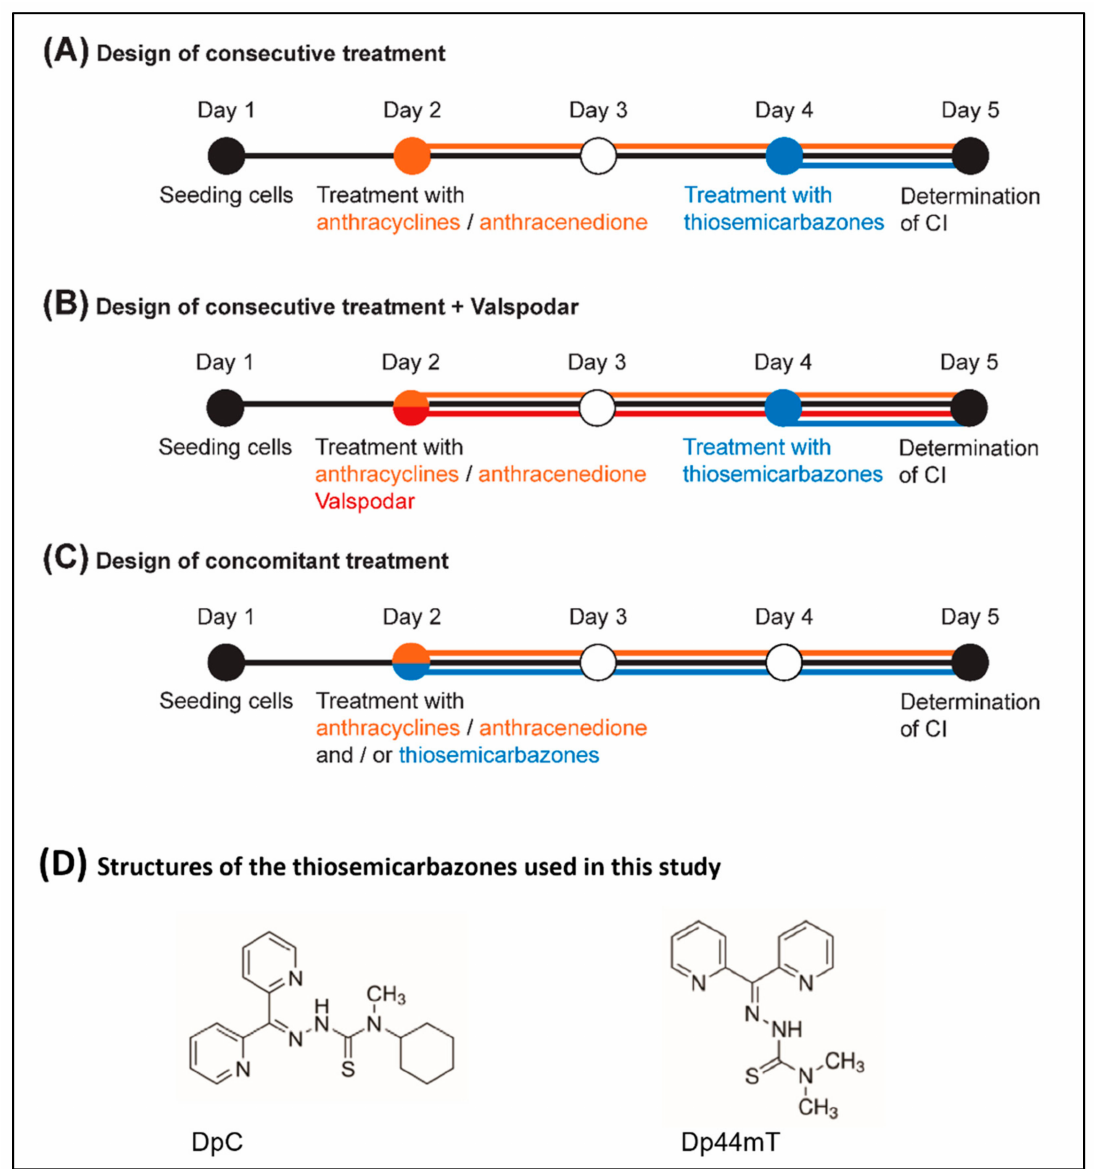
Figure 3. The three different combination treatment designs used in this study. ( A ) The de- sign of consecutive treatment included the pretreatment of cells for 48 h with an anthracy- cline/anthracenedione (either DOX, DAU, or MIT), and then either DpC or Dp44mT was added to the cells undergoing anthracycline/anthracenedione treatment for a period of 24 h. ( B ) To examine whether the mechanism of synergy was based on Pgp transport activity, Valspodar, a selective in- hibitor of Pgp, was added to the design of consecutive treatment. ( C ) In the design of concomitant treatment, both anthracycline/anthracenedione (either DOX, DAU, or MIT) and thiosemicarbazones (either DpC or Dp44mT) were added in combination to the cells and proliferation was evaluated after 72 h. ( D ) Structure of di-2-pyridylketone 4-cyclohexyl-4-methyl-3-thiosemicarbazone (DpC) and di-2-pyridylketone 4,4-dimethyl-3-thiosemicarbazone (Dp44mT). The computational analyses of synergy showed that the combination of a thiosemi- carbazone and anthracycline acted synergistically in four cell lines: SH-SY5Y, SK-N-BE(2), Daoy, and RD cells (Table 2). In the Saos-2 cell line, the analysis revealed moderate antago- nism for each compound combination (Table